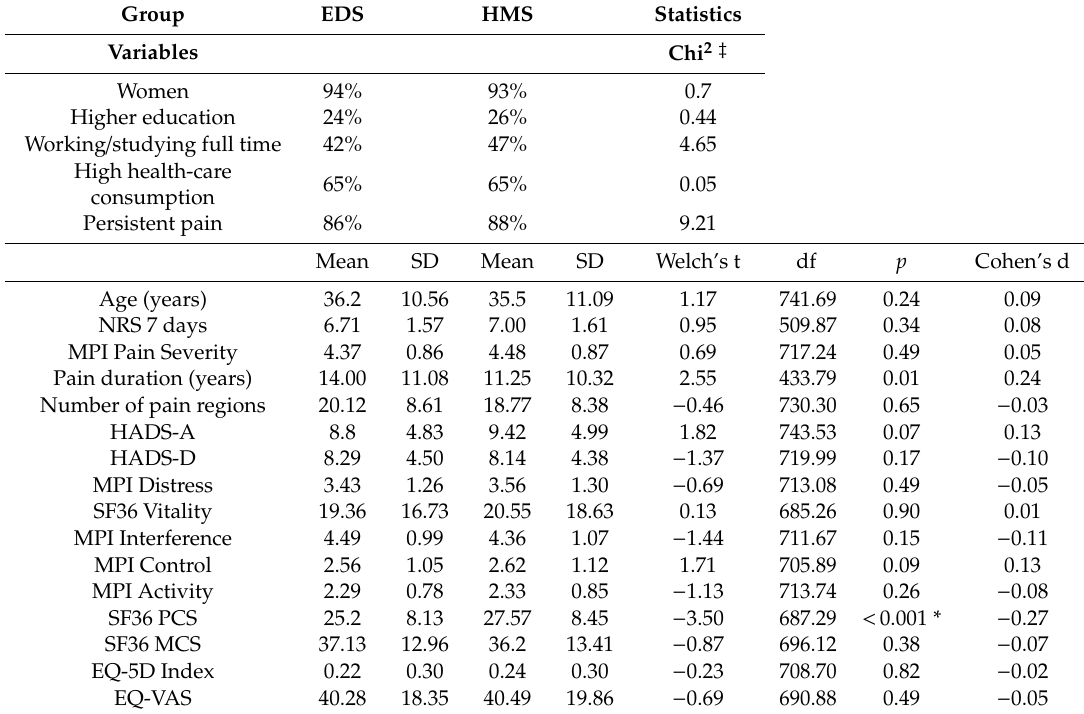
Table 1. Comparison between those coded with Ehlers–Danlos syndrome (EDS) and those with Hypermobility syndrome (HMS). For the categorial variables (upper part of the table) are given per centages and for the non-categorical variables (lower part of the table) mean and standard deviation (SD). Furthest to the right is presented the results of the statistical comparisons, Chi-square tests and Welch’s t test, respectively. For the non-categorical variables are presented with corresponding e ff ect sizes (Cohen’s d).